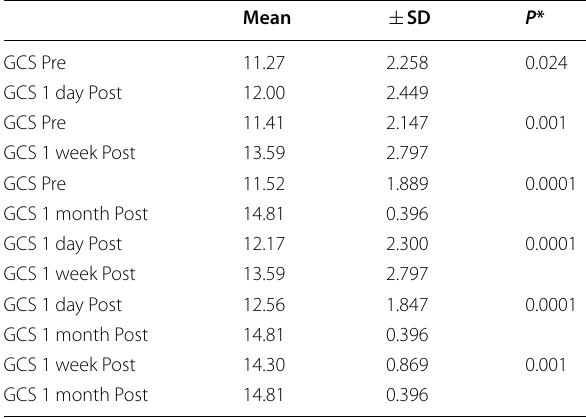
Table 4 Comparison between GCS values preoperatively and throughout the postoperative follow-up period